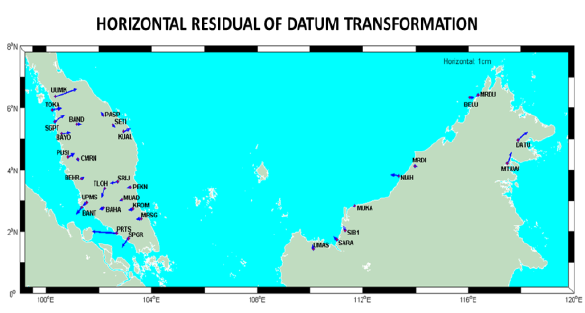
Figure 5 . Horizontal residual of Bursa-Wolf in Malaysia.